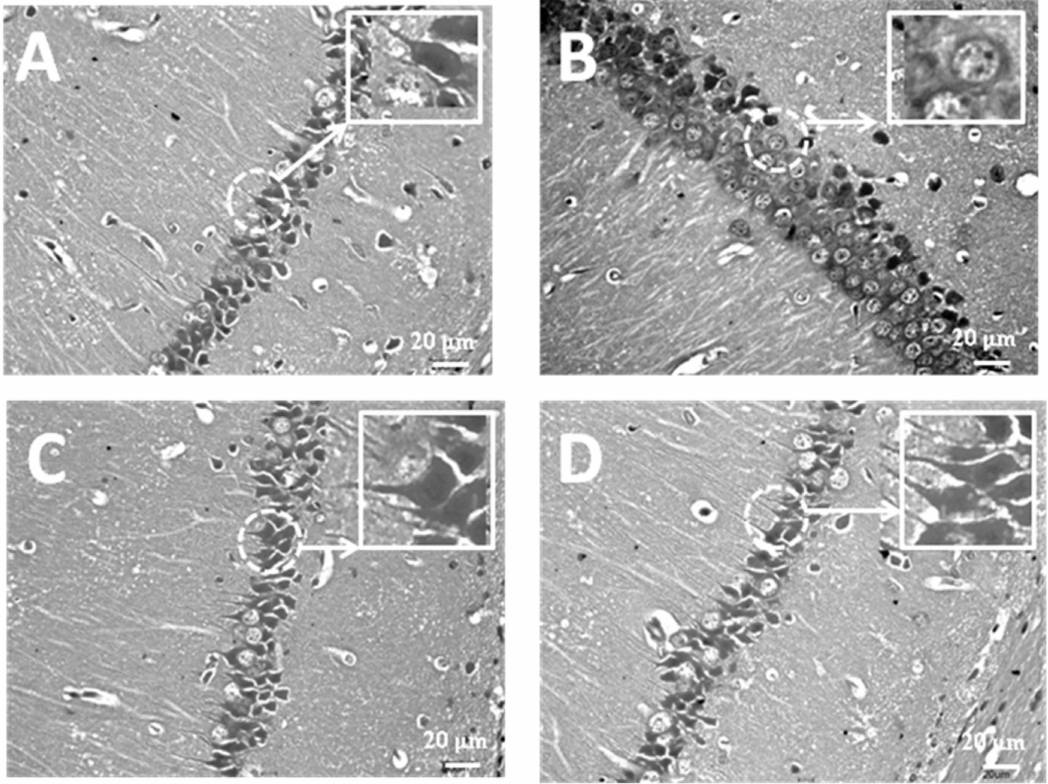
Figure 3. Histological observation shows gaseous FA exposure-induced hippocampal neurons death. ( A ) Control (Con); ( B ) FA exposure (FA); ( C ) MT injection (MT); ( D ) FA exposure with MT injection (FA + MT). Magnification: ˆ 40. Bar: 20 µ